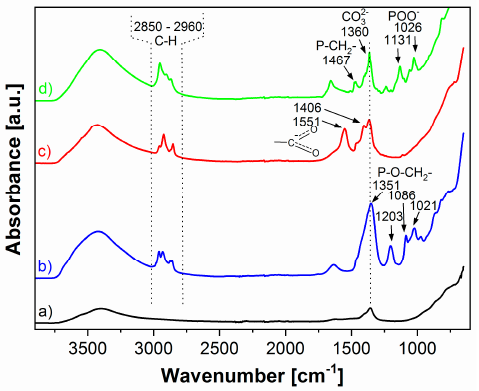
Figure 1. FTIR spectra of ( a ) pristine LDH, ( b ) LDH-phosphate, ( c ) LDH-decanoate, and ( d ) LDH-phosphinate.